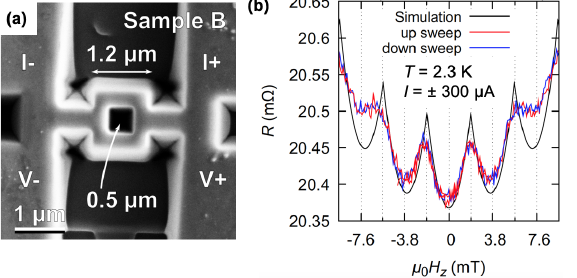
Figure 2. ( a ) Scanning electron micrograph of a rectangular SRO214 micro ring. ( b ) Magnetoresistance at 2.3 K with an excitation current of ± 300 µ A. The amplitude of oscillations matches well with the calculated Little-Parks oscillations. (Adopted with permission from [60] copyright APS